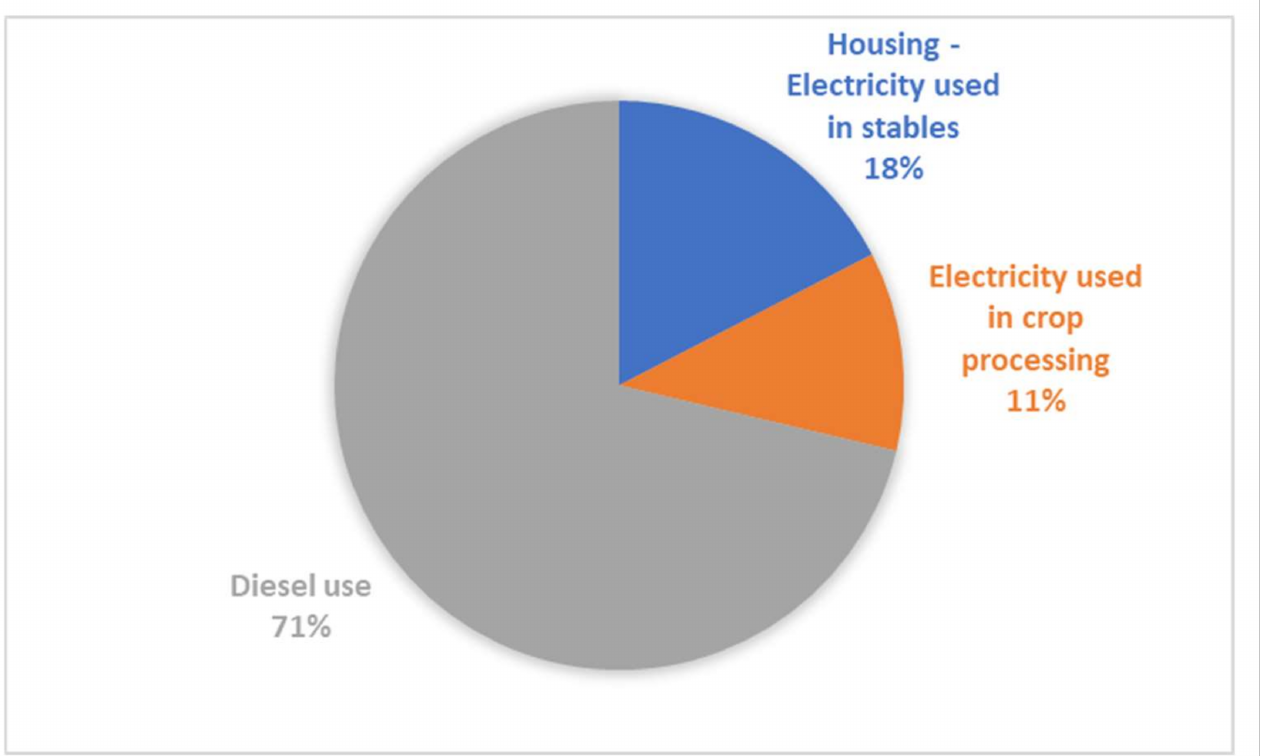
Figure 4. Direct energy inputs according to activity (based on